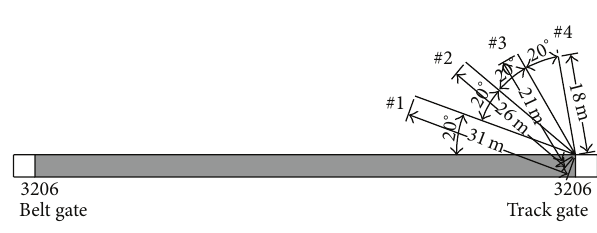
Figure 13: Schematic of the break-tip blasting (BTB) technique in the study